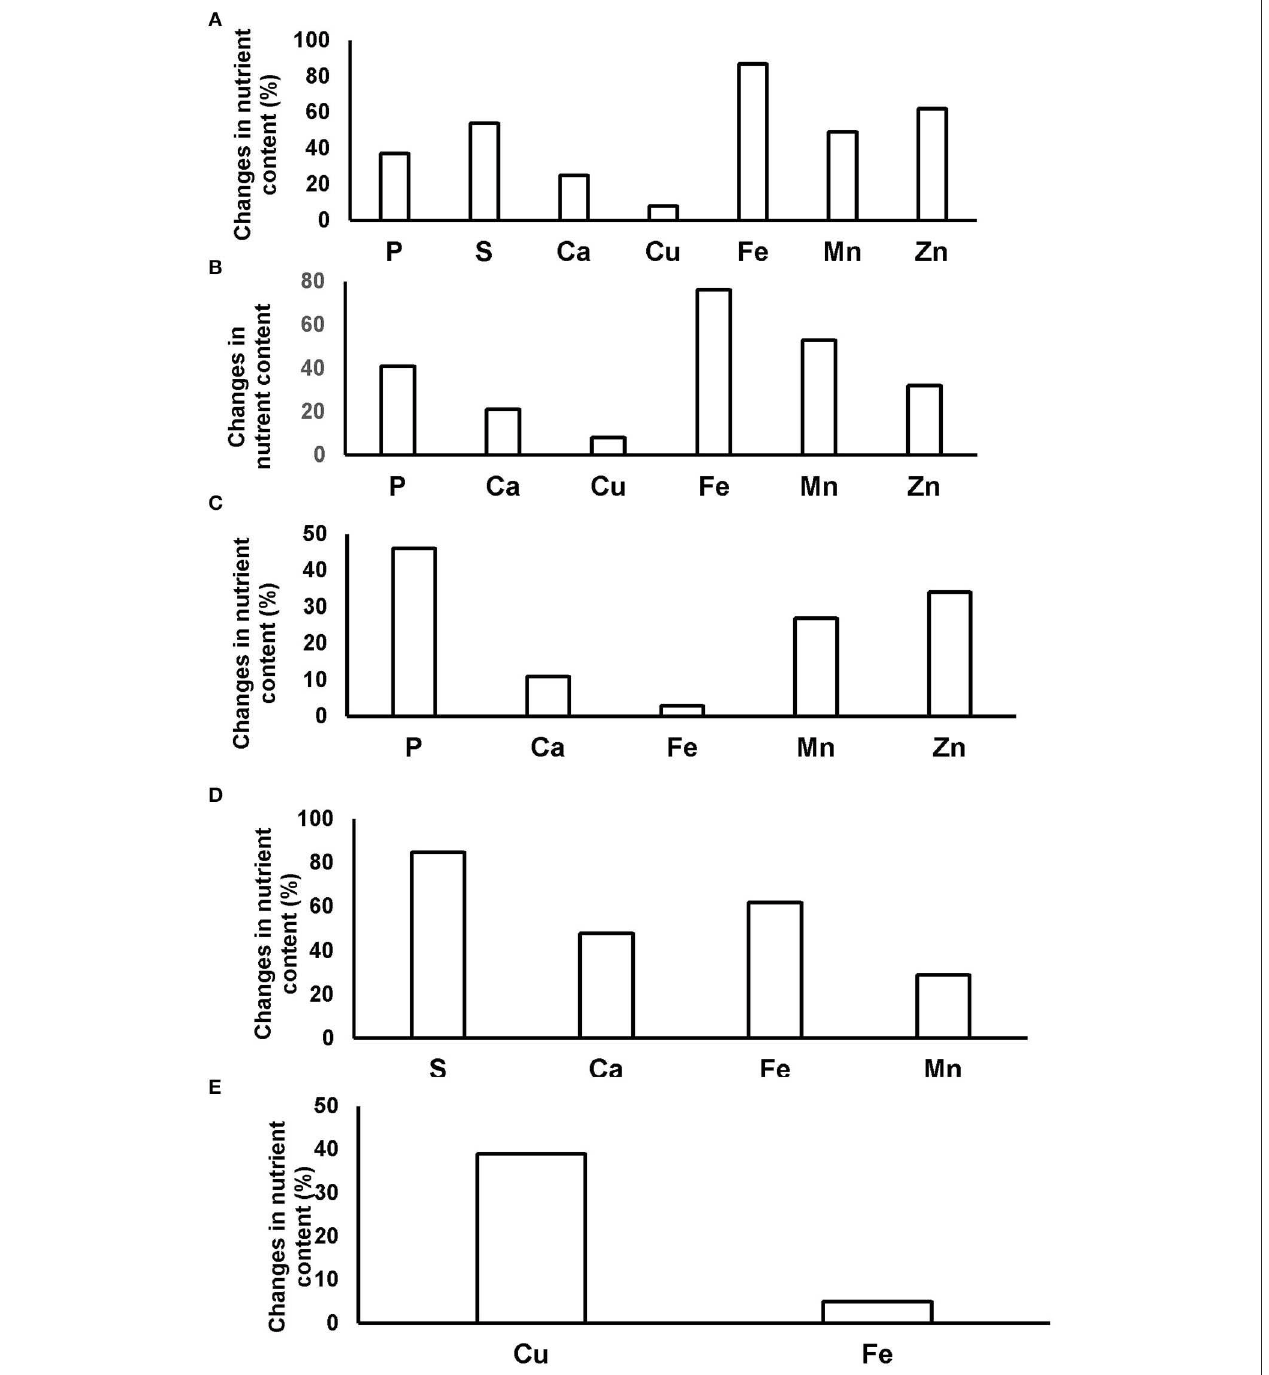
FIGURE 3 | Percentage increases in mineral nutrient composition of maize grain from zero-N plots of (A) mung bean, (B) Bambara groundnut, (C) black gram, (D) groundnut, and (E) cowpea over maize grain from zero-N plots of maize planted after maize. % mineral A = [(mineral A content of grain from zero-N plots of maize after legume–mineral A content of grain from maize planted after maize from zero-N plots)/(mineral A content of grain from maize grown after maize from zero-N plots)] × 100. Minerals not shown in Figure 3 did not change significantly relative to maize after maize from zero-N plots. (Eaglesham et al., 1981), enhancing the N-sparing